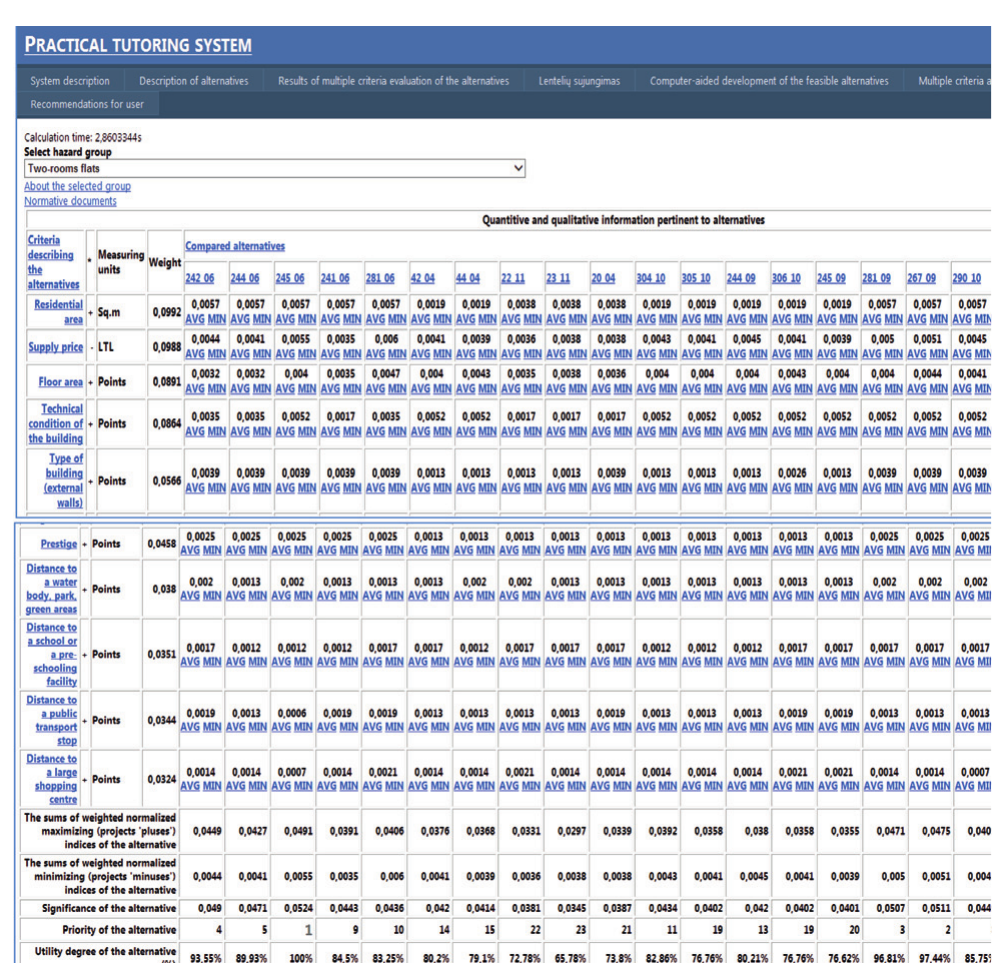
Fig. 3. Quantitative and qualitative description of alternative flats for sale